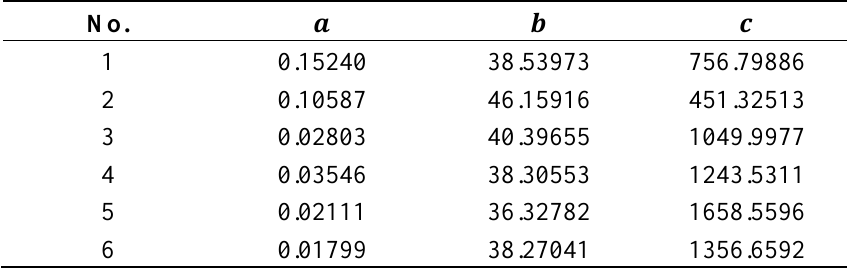
Table 2. Fuel cost coefficients.